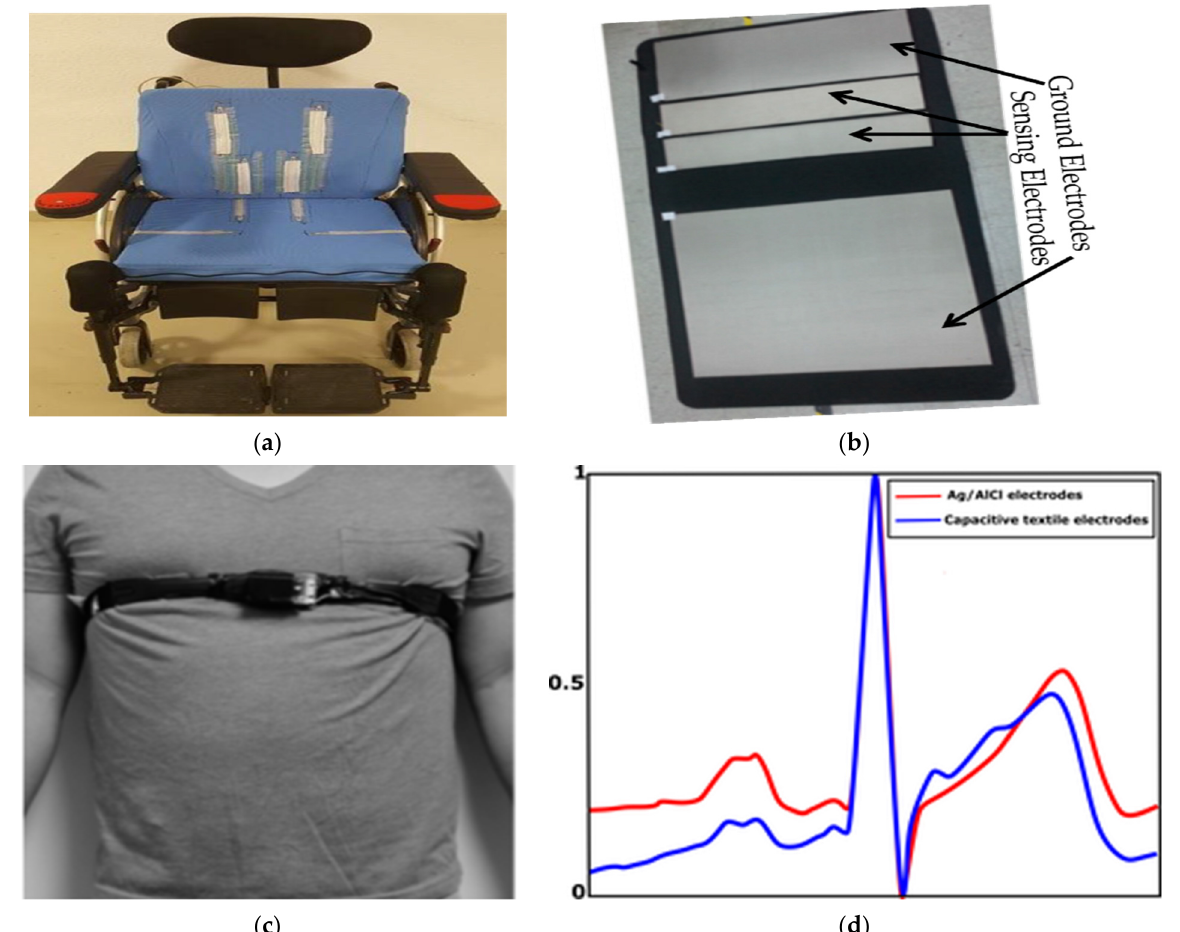
Figure 4. Non-contact metal integrated textile electrodes and typical results: ( a ) textile electrodes integrated into a wheelchair [75]; ( b ) smart mattress with textile electrodes, adopted from [71]; ( c ) a person wearing a strap with an ECG sensor (a foam coated with Ni/Cu) around the lower chest over her t-shirt, adapted from [67]; ( d ) normalized ECG waveforms measured from Ag/AgCl electrodes (red line) and capacitive textile electrodes (blue line), adapted from [71].